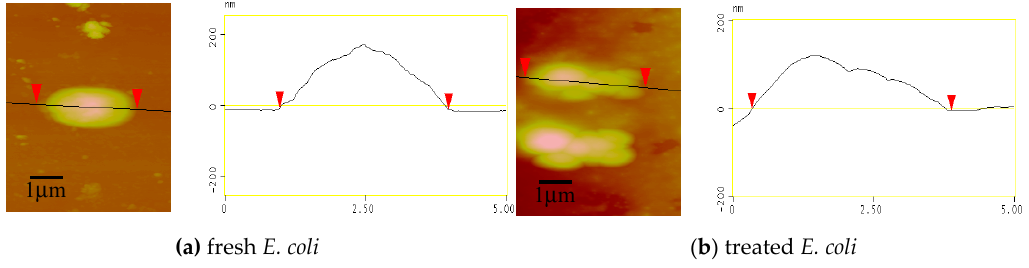
Figure 5. Height and section images of fresh ( a ) and treated E. coli ( b ) revealed by atomic force microscopy (AFM).